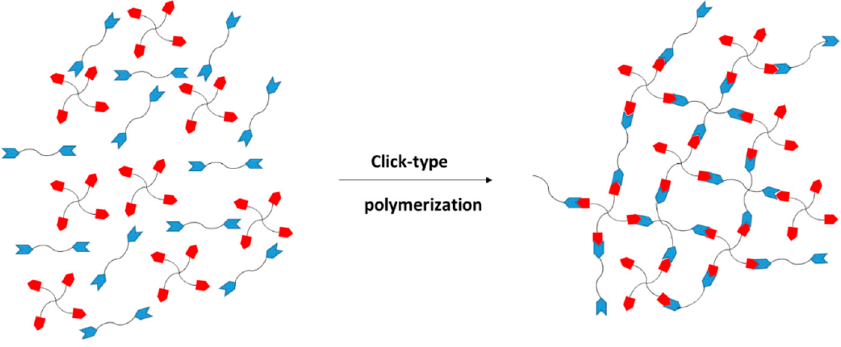
Figure 1. Schematic representation of the crosslinking process using click reactions.